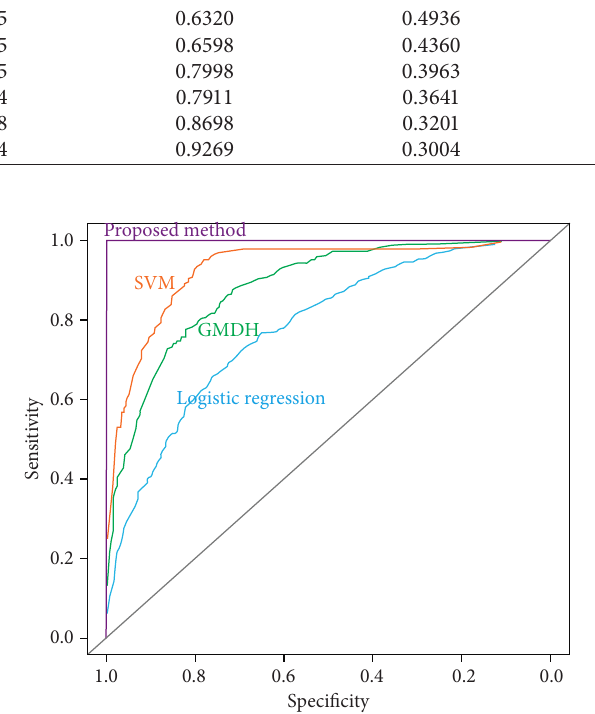
Figure 4: ROC from same training data on different classifiers.